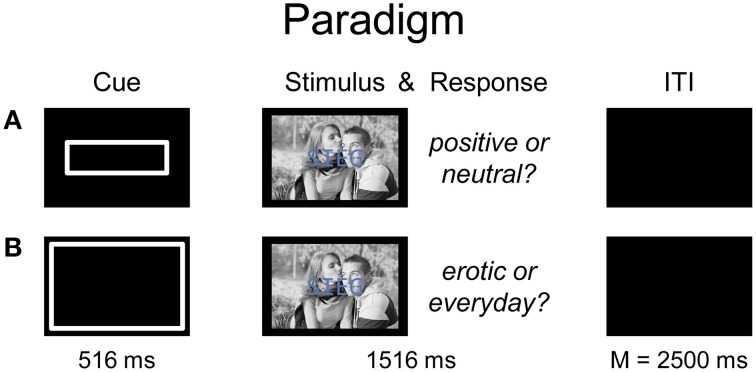
Illustration of the trial sequence. A pre-stimulus box cue indicated whether participants should categorize the word (A) or the picture (B) in the present trial. Then the compound picture-word stimulus was displayed, and the participant responded. During a variable inter-trial-interval, a blank screen was shown before the next pre-stimulus cue was presented. Please note that the photograph used in Figure 1 is shown for exemplary reasons and was not part of the stimulus set [“love” by Richard foster (https://www.flickr.com/photos/93963757@N05/8550837497), used under CC BY-SA 2.0 (https://creativecommons.org/licenses/by-sa/2.0/), decolorized from original].